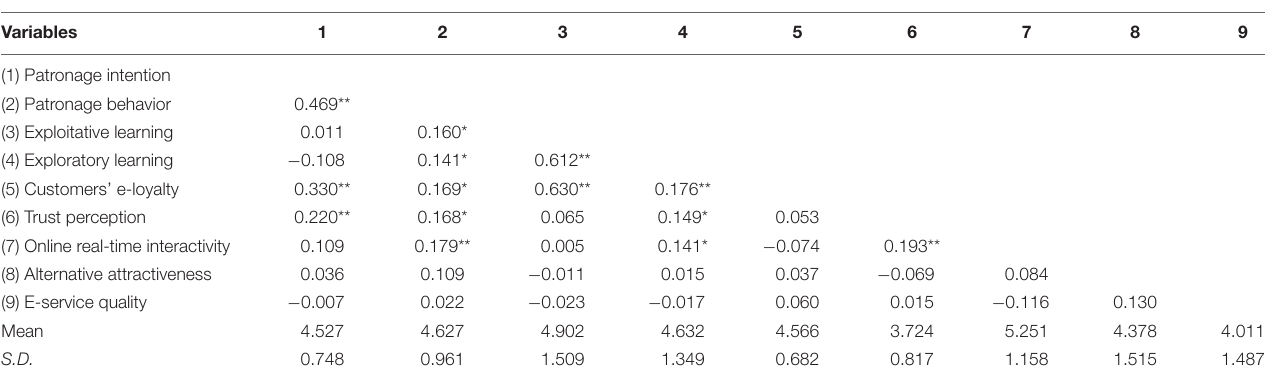
TABLE 3 | Descriptive statistics and Pearson’s Correlation Matrix ( N =